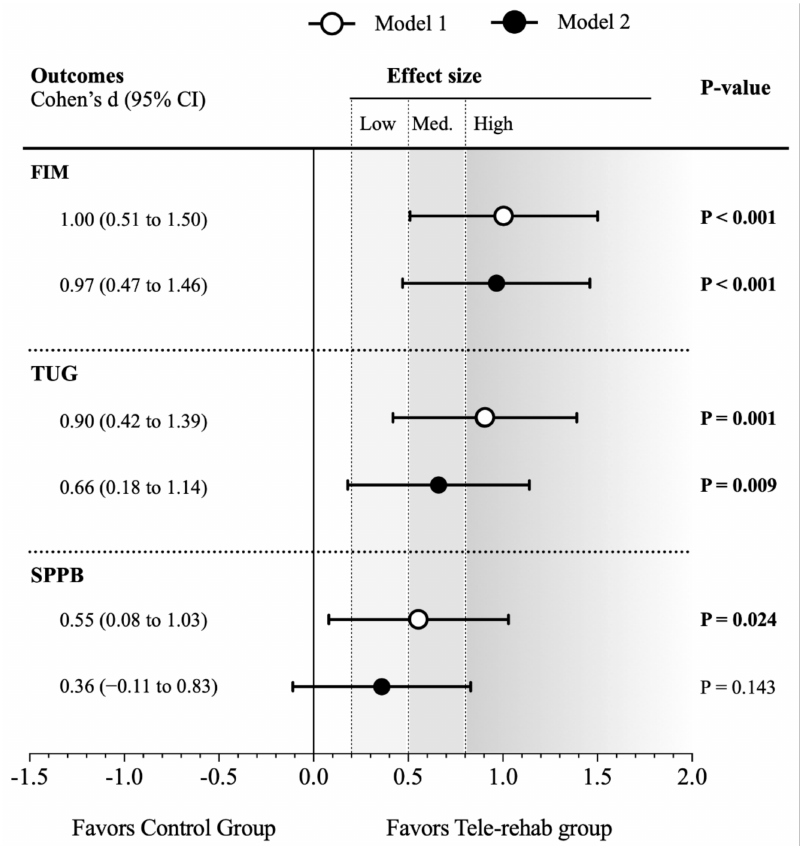
Figure A1. Effect sizes of the ActiveHip project on functional independence and physical performance in the intention-to-treat